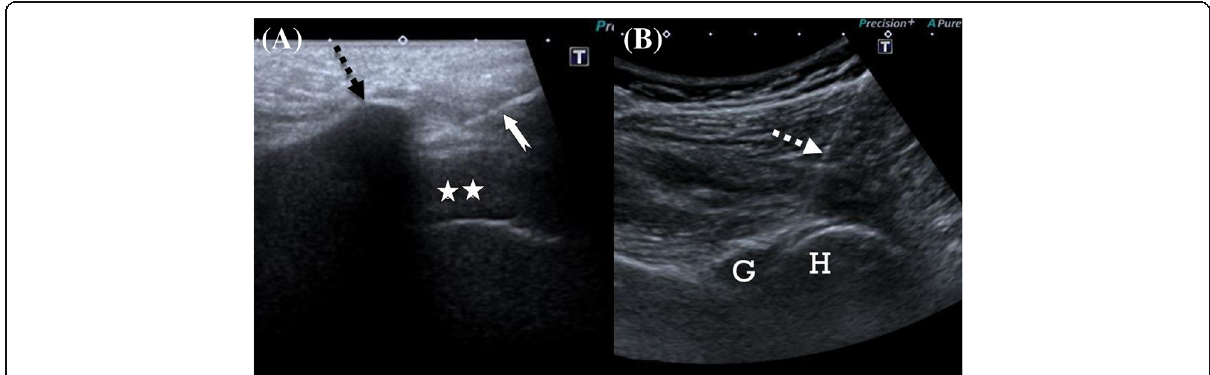
Fig. 1 a Coronal sonographic image through the distal acromion (dashed arrow) shows the inserted needle (white arrow) and its tip within the sub-acromial space. Note the distal supraspinatus tendon (stars). b Axial sonographic image through the gleno-humeral joint showing the needle track (arrow) with its tip within the gleno-humeral interval. G, glenoid; H, humeral head